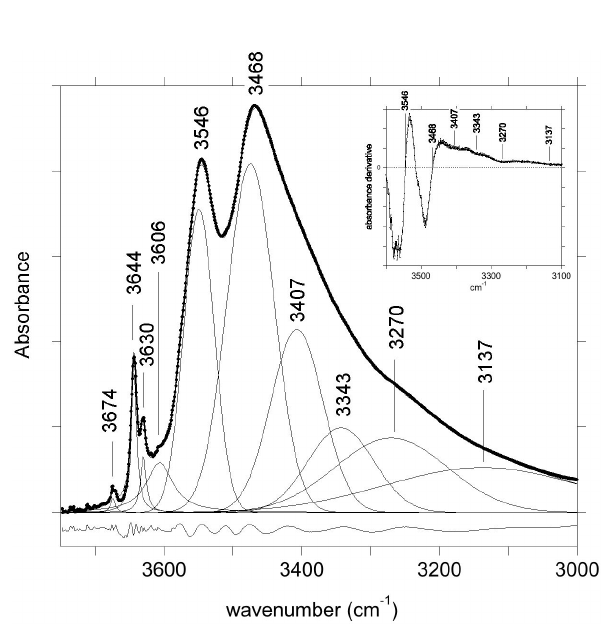
Figure 2. Powder infrared absorption spectrum of the LH12 sam- ple in the OH-stretching range. The spectrum was decomposed into individual components (Table 1). The inset shows the first deriva- tive spectrum that was used to assess the position of the four broader components accounting for the low-frequency tail of the broad peak at 3468cm − 1 . The residue reported at the bottom was arbitrarily shifted for clarity’s